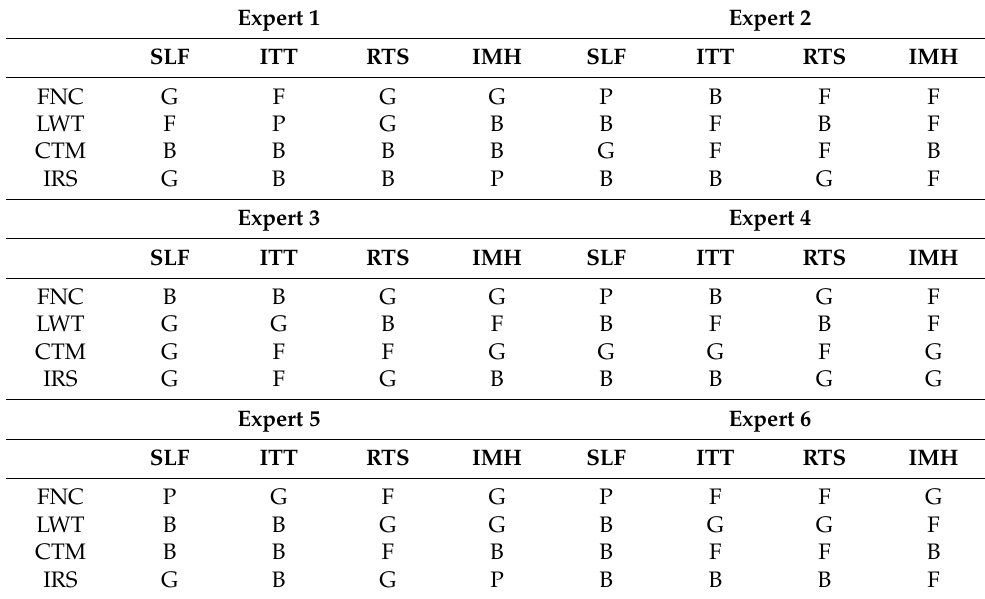
Table A13. Linguistic evaluations of experts for the positive and negative degrees of competencies.